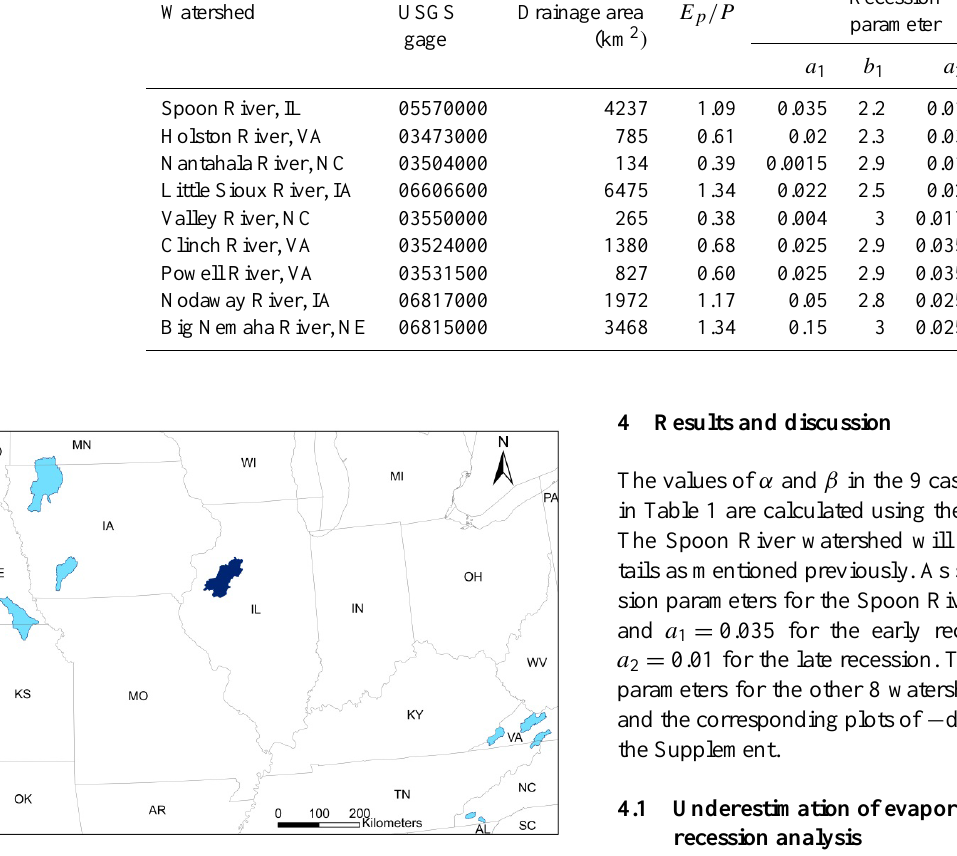
Fig. 2. Locations of the 9 study watersheds with Spoon River watershed located in Illinois and highlighted in dark blue.